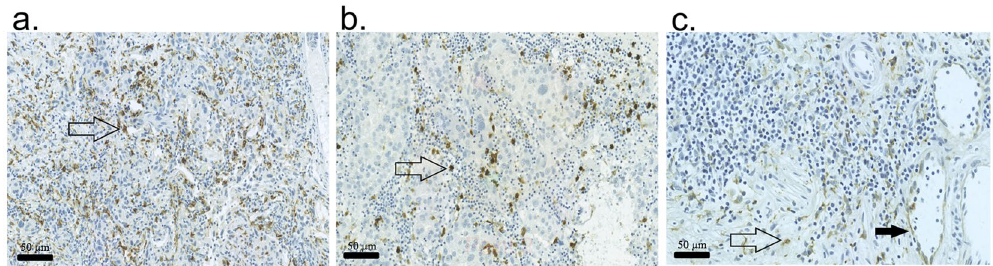
Figure 1. Representative examples showing immunohistochemical stainings of studied markers in TUR-BT specimens. Examples of ( a ) CD68, ( b ) MAC387, and ( c ) CLEVER-1 staining patterns. ⇧ indicates positively stained macrophages, indicates a positive CLEVER-1